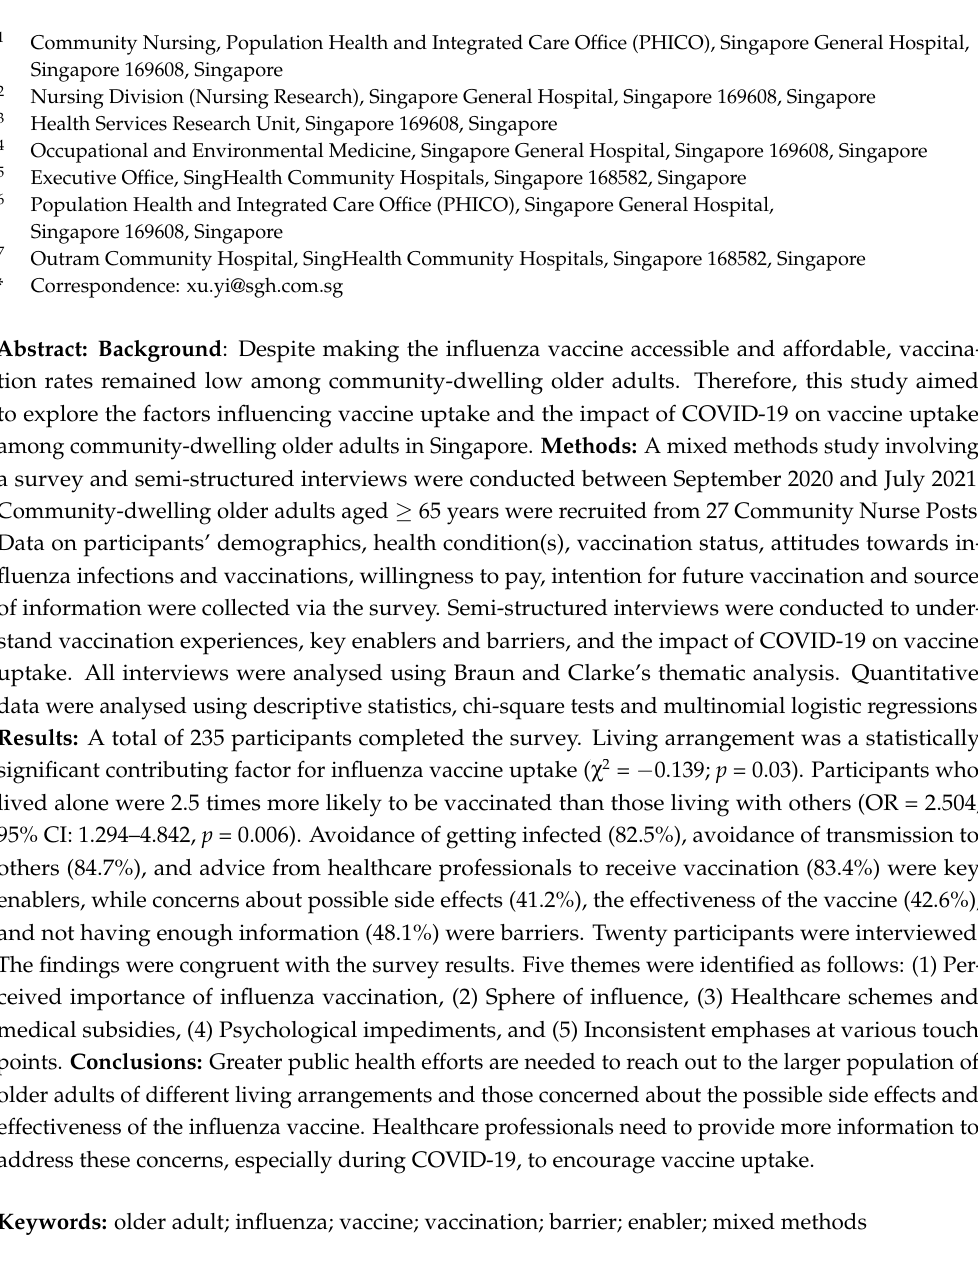
Table 2. Multinomial logistic regression comparing vaccinated (N = 93) and non-vaccinated (N =